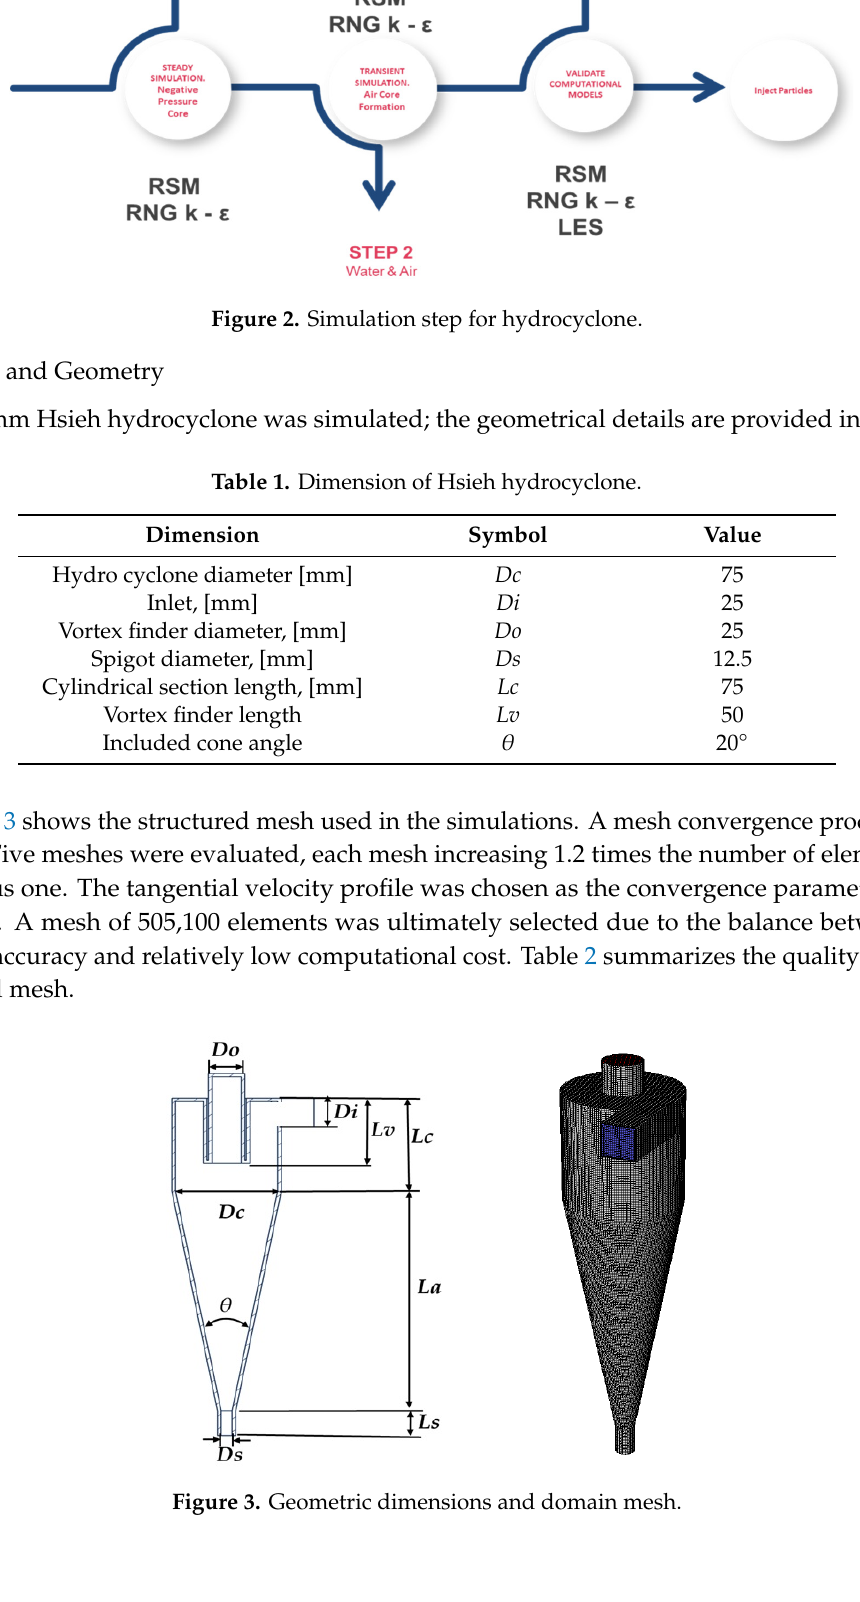
Figure 4. ( a ) Mean tangential velocity profile from Reynolds stress model (RSM) simulation on four different grid sizes at 60 mm from hydrocyclone Hsieh top, ( b ) Mean axial velocity profile from RSM simulation on four different grid sizes at 60 mm from hydrocyclone Hsieh top.